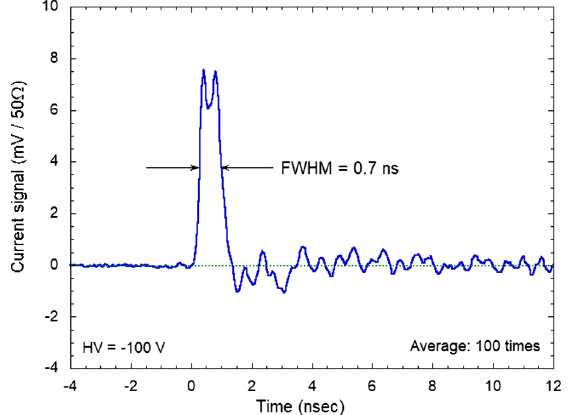
FIG. 17. Typical pulse waveform of the current signal. An oscilloscope (4 GHz B. W., 20 GS = s, 100-time average) is used for pulse waveform observation. The baseline is marked with a dotted line.